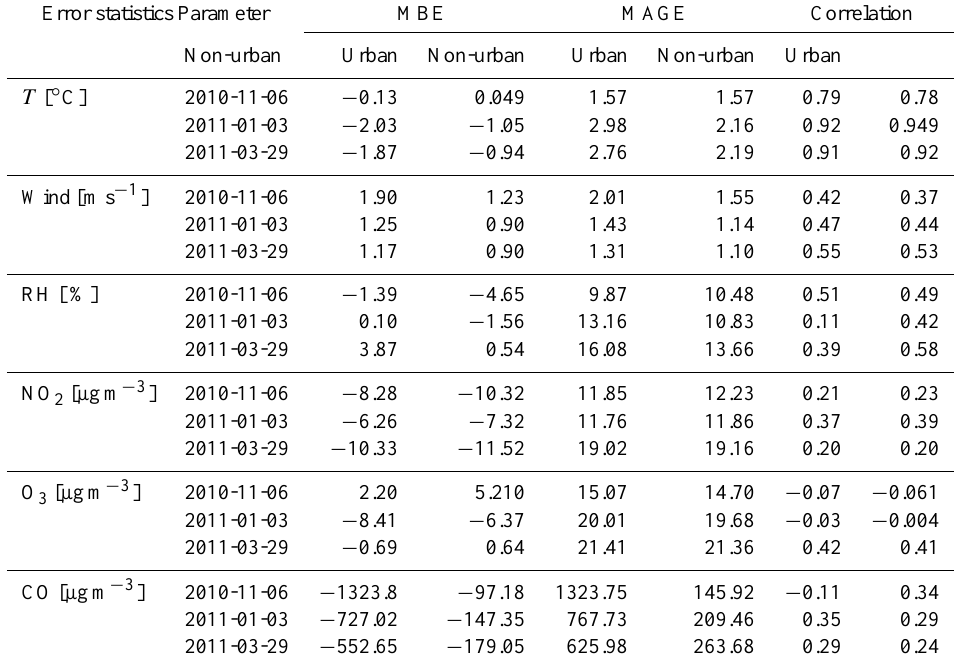
Table 3. Statistical error measure averaged over